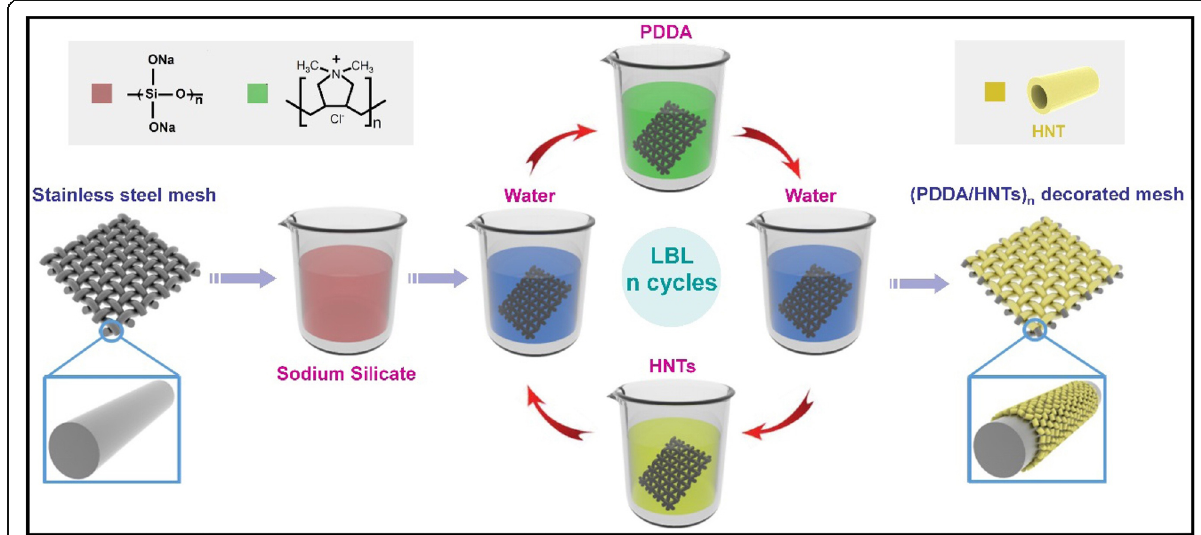
Fig. 5 Schematic illustration of LBL assembly process for the fabrication of the (PDDA/HNTs)n decorated mesh